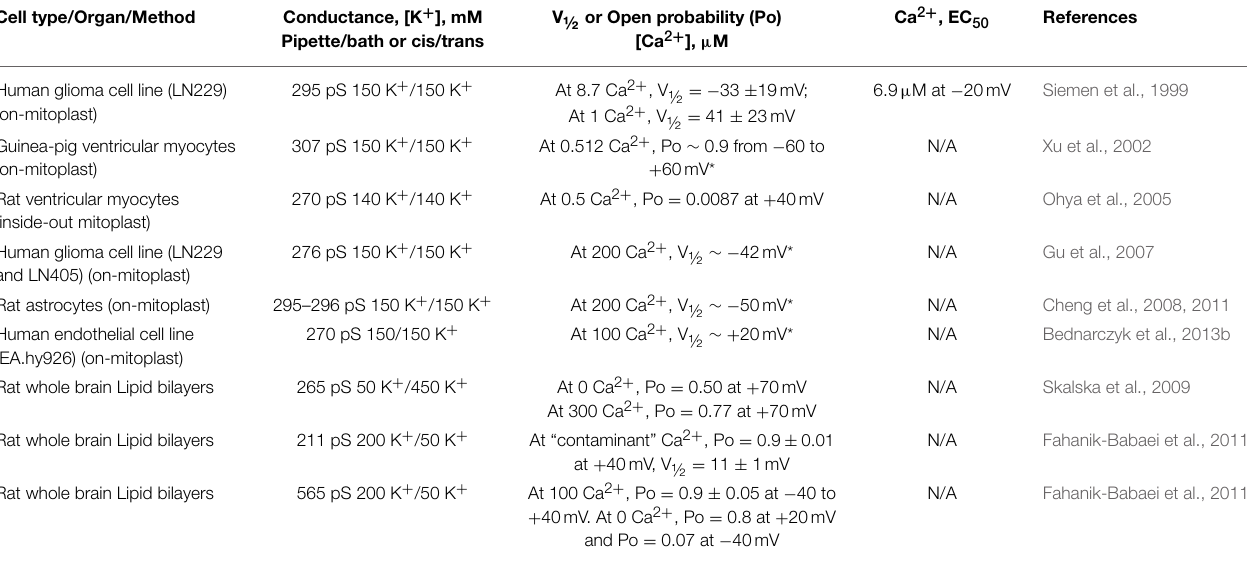
* Estimated from published figure. On-mitoplast is also called mitoplast-attached configuration of the patch clamp technique. Abbreviations: V½, half activation potential or potential where an open probability of 0.5 is achieved; EC 50 , concentration of half maximal effect; N/A, not available.